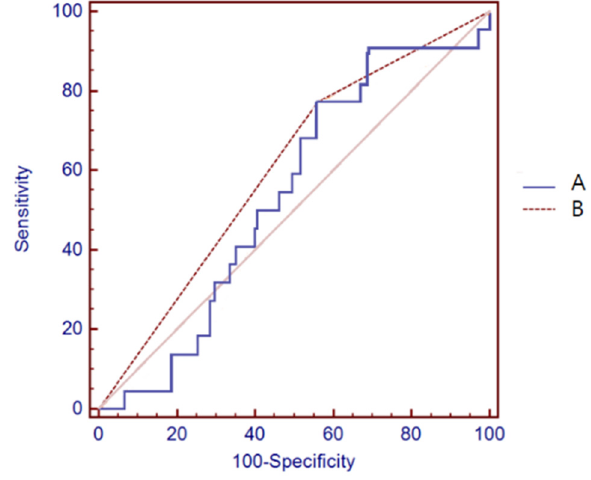
Figure 3. ROC curve for cut-off values of visceral fat area. Calculate all log-rank statistics and optimal cut-off value which is 67.7cm 2 was selected using largest Q statistic index. Receiver Operating Characteristic (ROC) curves obtained for the visceral fat area measured by bioelectrical impedance analysis (A) and area under the ROC curve (AUC) was 0.538. When we divide two groups using the cut-off values, AUC was 0.606 (B).